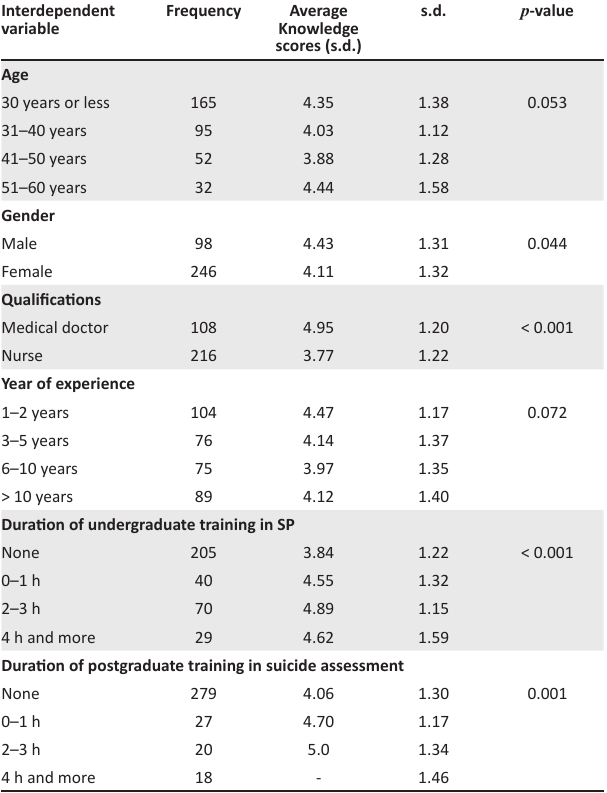
TABLE 2: Association between background characteristics and knowledge of suicide. Interdependent variable